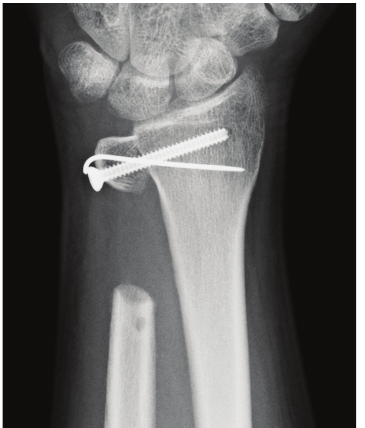
Figure 4: One year after the operation, X-ray showed no recurrence of the tumor, no absorption of the grafted bone, and no ulnar translation of the entire carpus. There was no convergence of the proximal stump of the ulna toward the